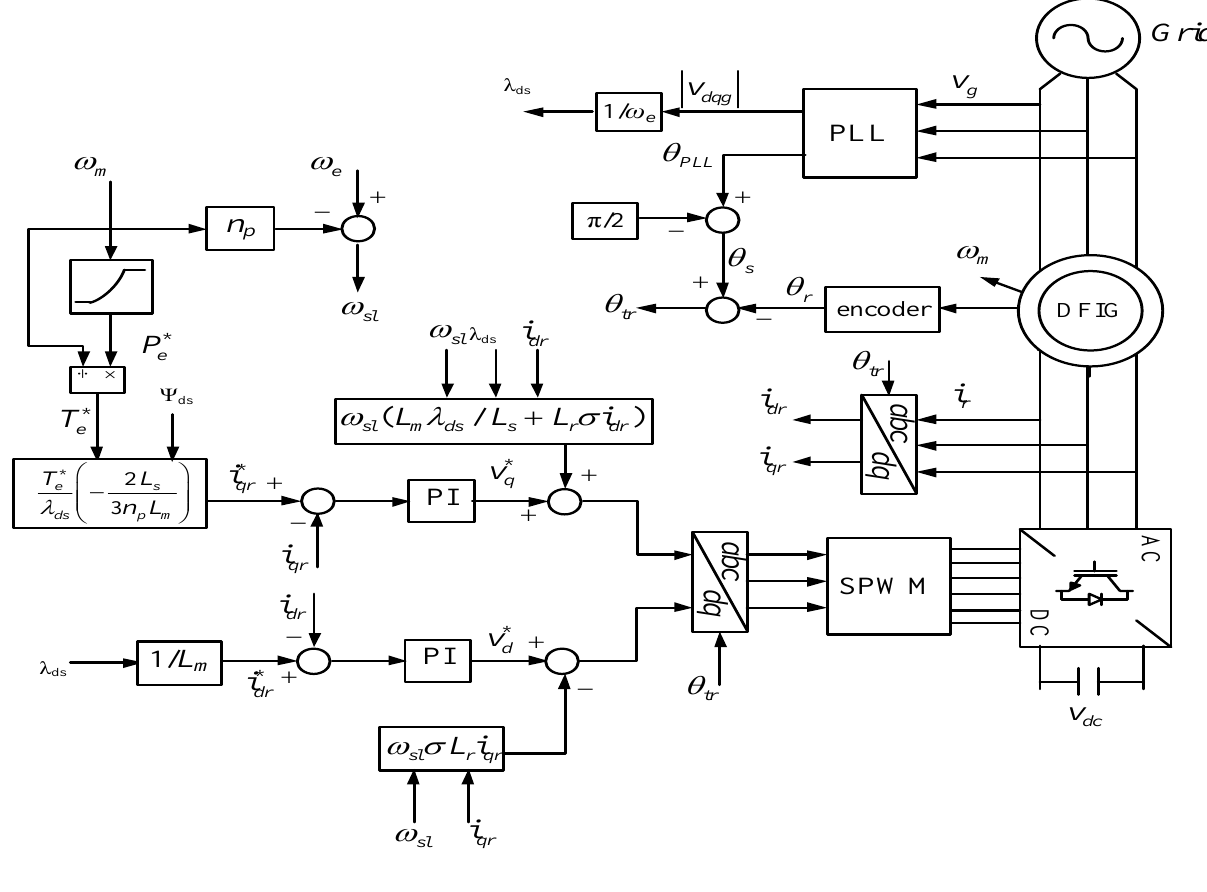
Figure 4. Rotor side converter control block diagram.